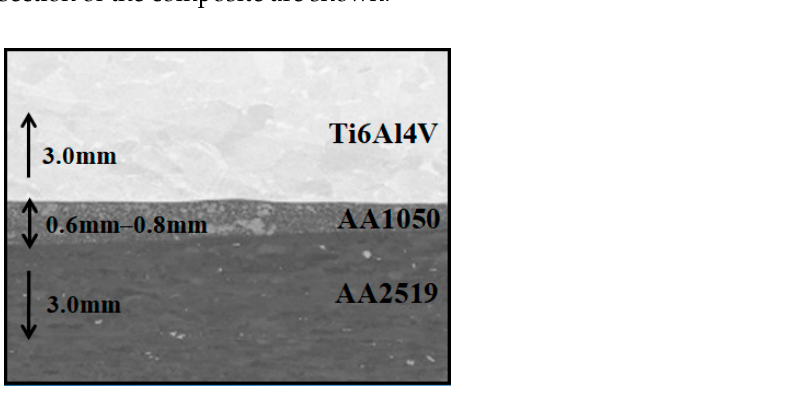
Figure 8. Explosive welded sheet of AA2519–Ti6Al4V with interlayer of AA1050) a metallographic cross-section of the composite.